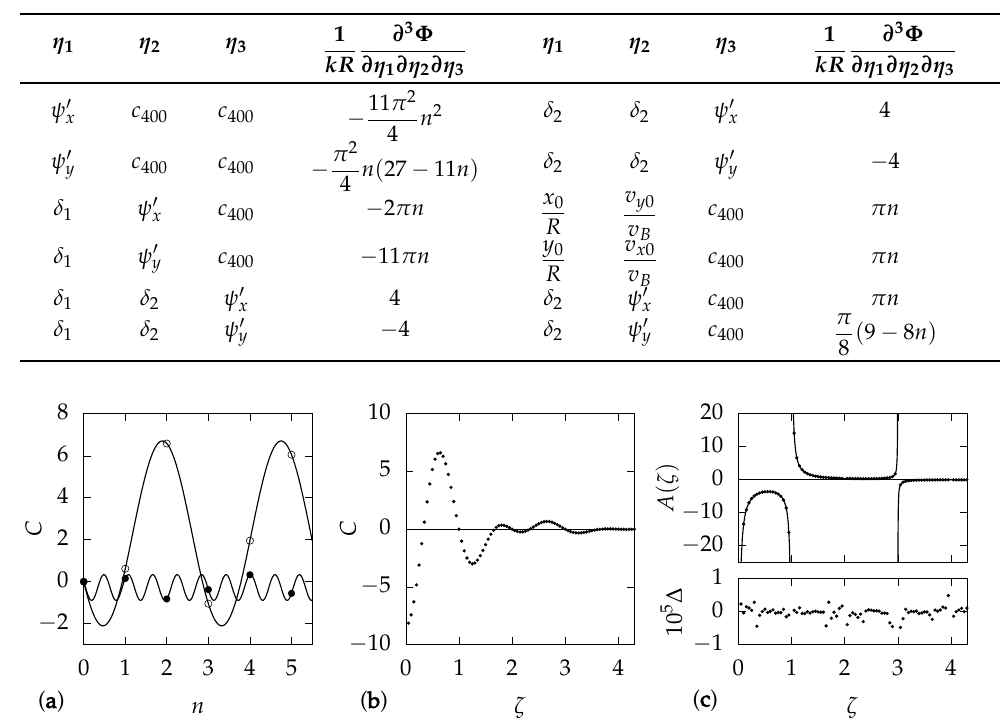
Table 3. Third-order sensitivities in the case of a trap with perfect cylindrical symmetry, for n orbits with ζ = 1.